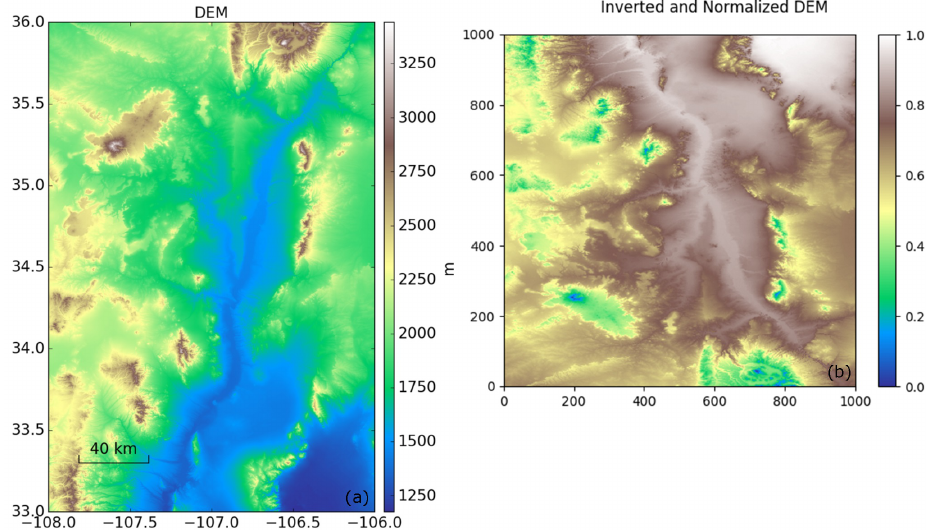
Figure 3. ( a ) The digital elevation model (DEM) of the Socorro Magma Body located in New Mexico, USA, from the Shuttle Radar Topography Mission (SRTM), with 1 arc-second ( ≈ 30 m) resolution and ( b ) an inverted, normalized, flipped, and resampled DEM used to compute the phase delay due to vertical stratification.